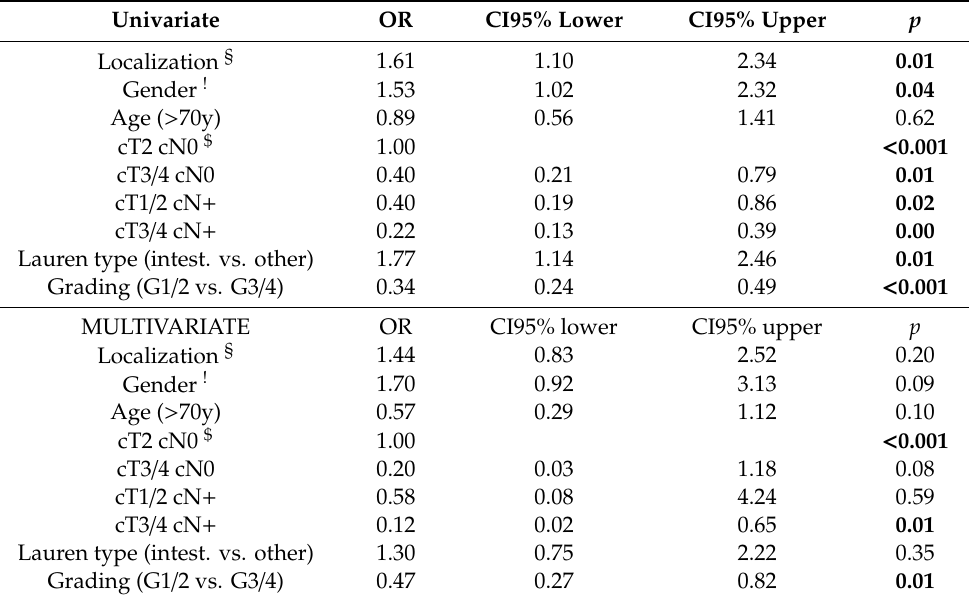
Table 5. Uni- / multivariate analysis for the predictors of